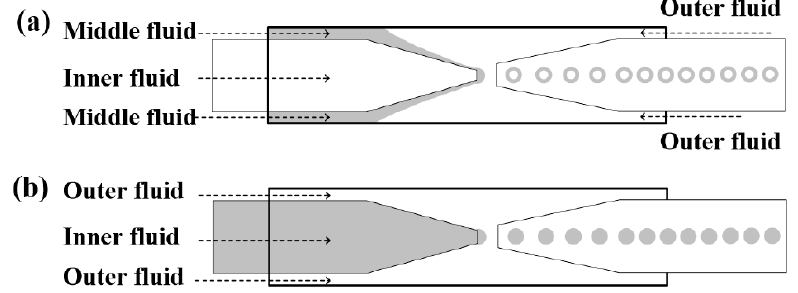
Figure 1. Schematic diagrams of glass capillary microfluidic setups for producing ( a ) water-in-oil-in-water (W/O/W) double emulsion microshells and ( b ) oil-in-water (O/W) microdroplets.